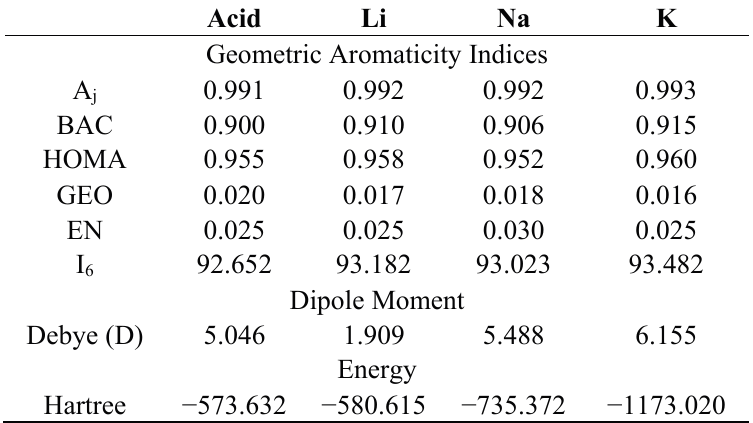
Table 2. The calculated aromaticity indices, dipole moments (Debye) and total energy (Hartree, 1 hartree = 2625.5 kJ/mol) calculated using B3LYP/6-311++G** method for trans o -coumaric acid and o -coumarates lithium, sodium and